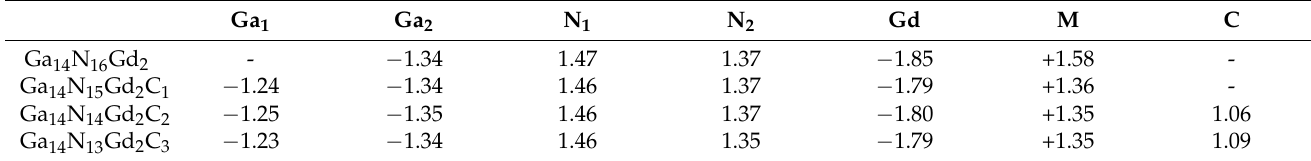
Table 1. Calculated Bader analysis for Ga, N, Gd and C (except for M site) atoms, respectively. The M site is located between the two Gd atoms. Ga 1 and Ga 2 represent the Ga atom bonded with and without C, respectively, whereas N 1 and N 2 display the N atoms bonded with and without Gd atoms, respectively. The accumulation and depletion of electrons are indicated by + and − , respectively. The unit of all data is